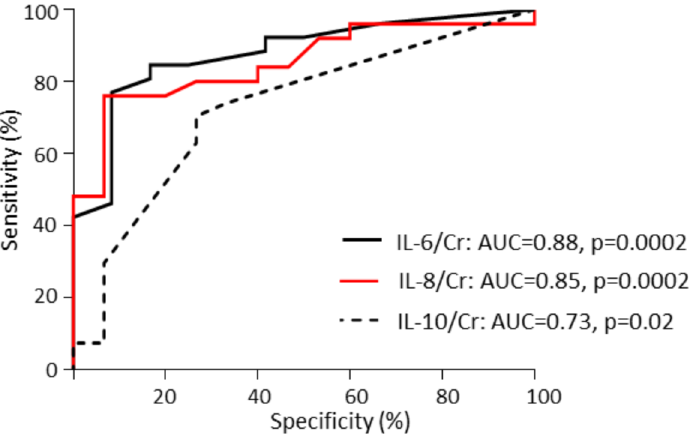
Fig 4. ROC curves of urinary cytokines comparing the IgAV-woN and IgAV-N groups.